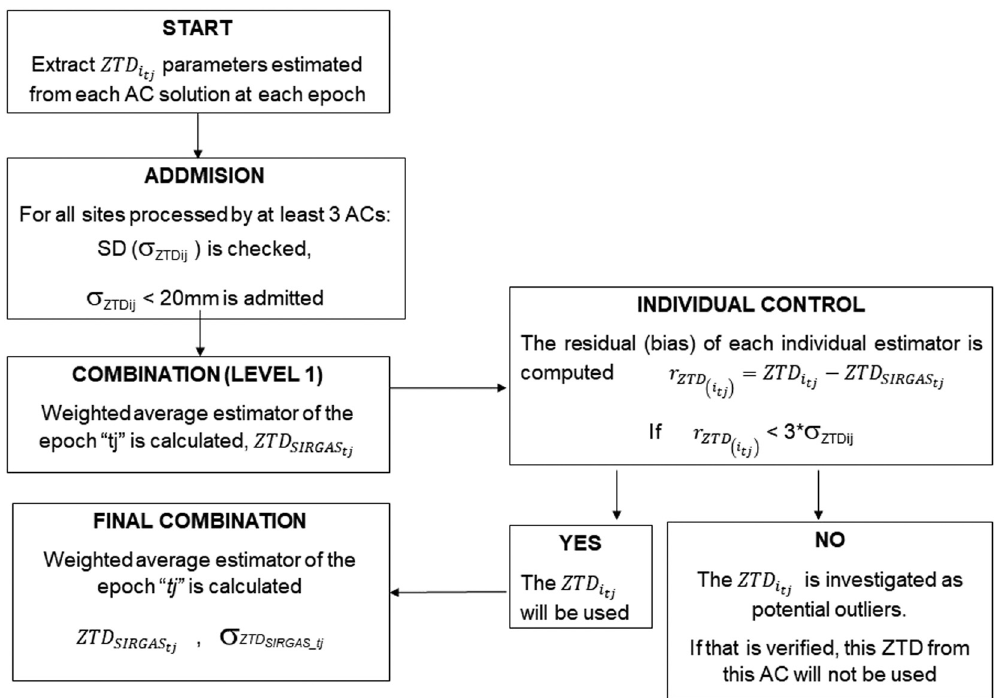
Figure 2: ZTD combination strategy at CIMA. Admission, quality control and fi nal combined solution.